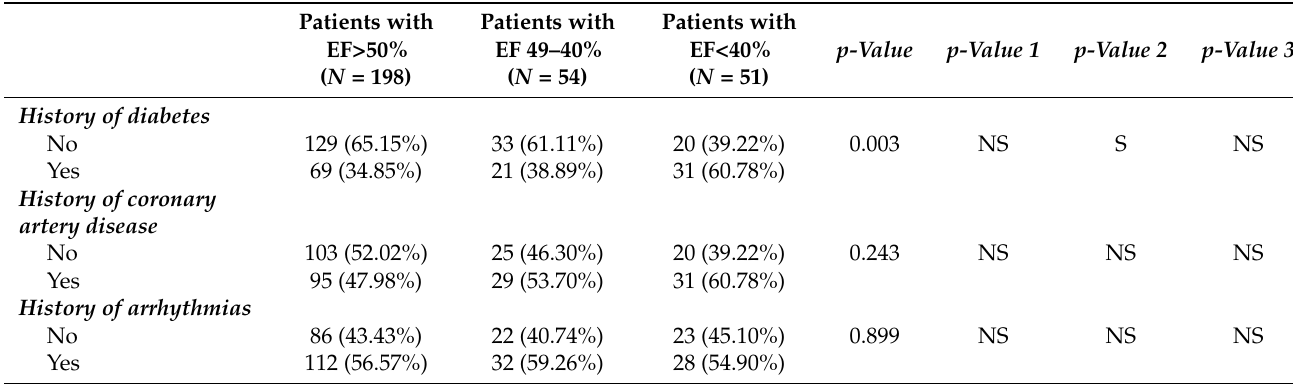
Table 2. Summary of